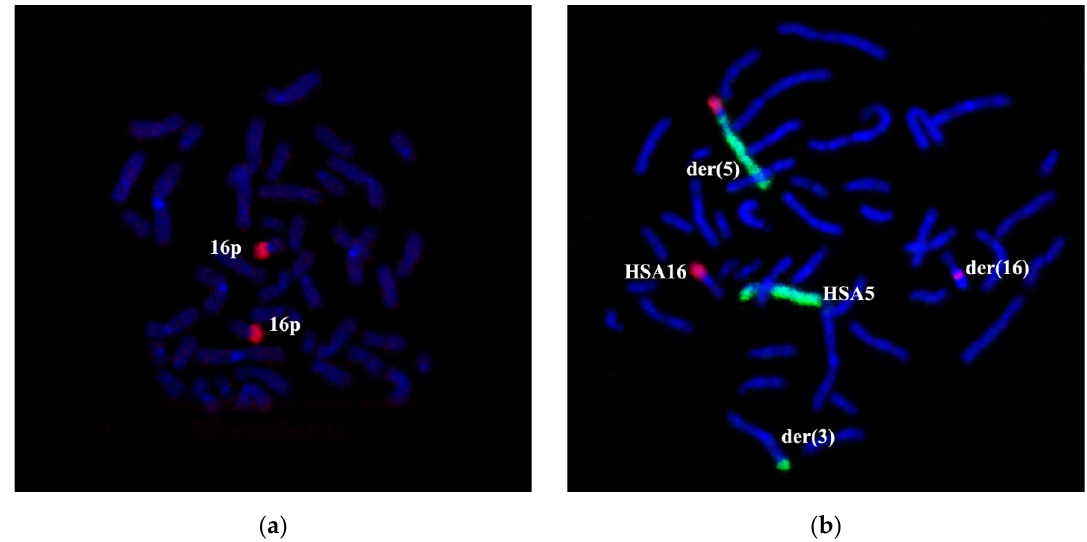
Figure 5. CISS hybridization with PCP16p ( a ) and WCP5 (green) / PCP16q(red) ( b ) on the patient’s metaphase chromosomes. ( a ) PCP16p DNA probe that is homologous to the short arm of chromosome 16 (red). Chromosomal regions where the specific signal was detected are indicated: 16p—short arms of chromosomes 16 and chromosome 16 derivative. ( b ) Chromosomal regions where the specific signal was detected are indicated: HSA5, HSA16—intact chromosomes 5, 16. der(3), der(5), der(16)—chromosomes 3, 5, and 16 respective derivatives. Chromatin DAPI staining is in blue.